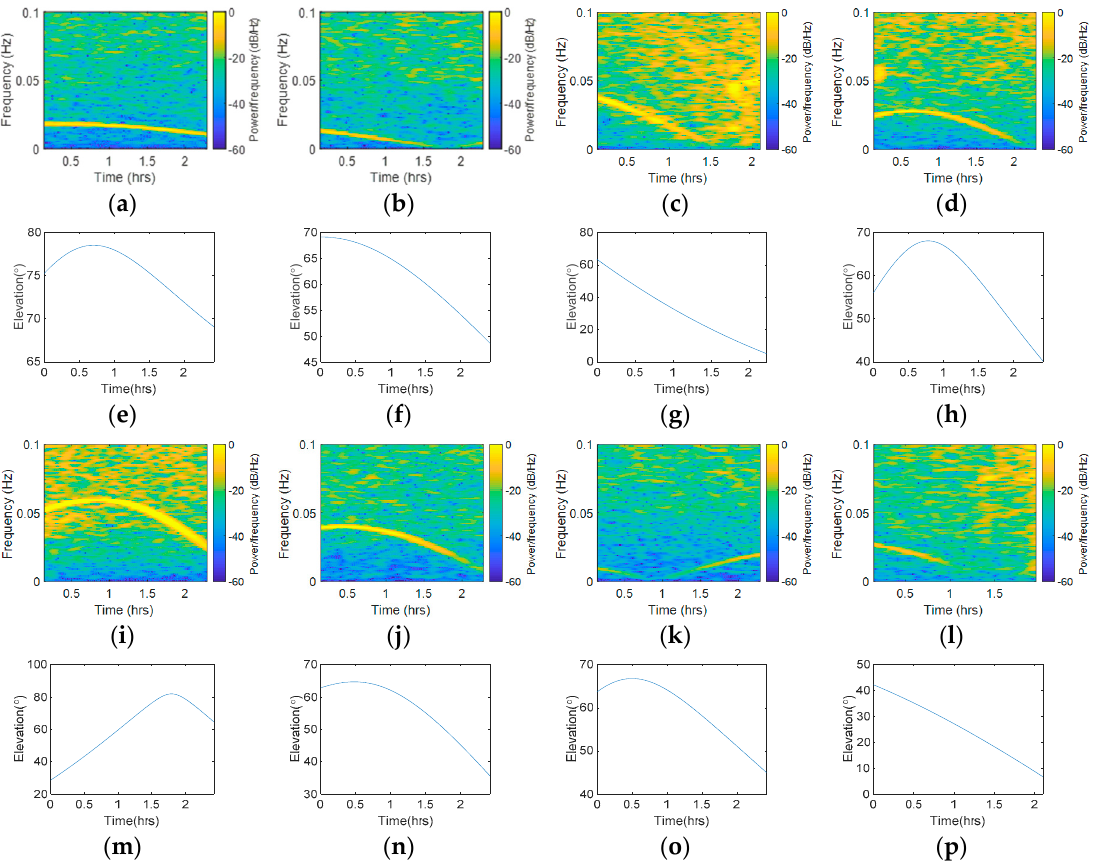
Figure 14. STFT and elevation results of Site A, ( a ) C06, STFT, ( b ) C08, STFT, ( c ) R04, STFT, ( d ) R05, STFT, ( e ) C06, Elevation, ( f ) C08, Elevation, ( g ) R04, Elevation, ( h ) R05, Elevation, ( i ) R20, STFT, ( j ) G02, STFT, ( k ) G05, STFT, ( l ) G06, STFT, ( m ) R20, Elevation, ( n ) G02, Elevation, ( o ) G05, Elevation, ( p ) G06, Elevation.